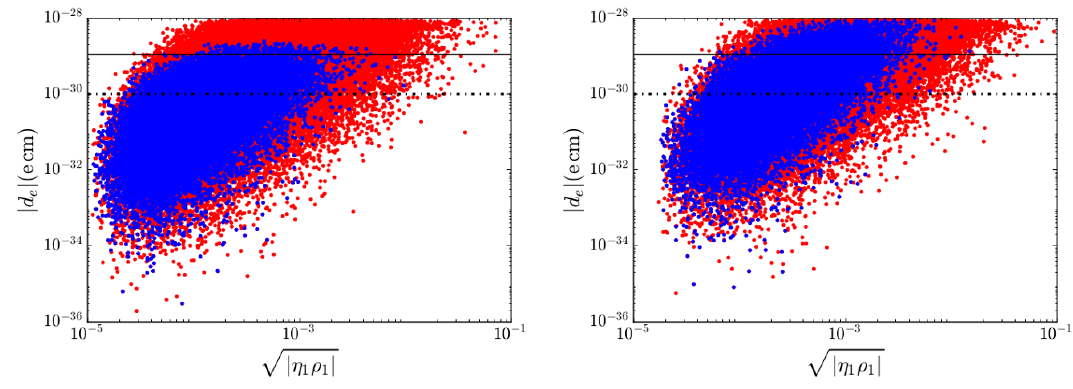
p j (cid:17) 1 (cid:26) 1 j for NH (left panel) and IH